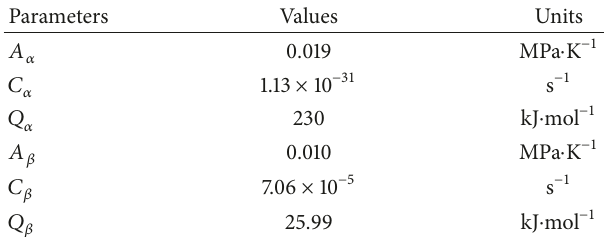
Table 1: Ree-Eyring constants